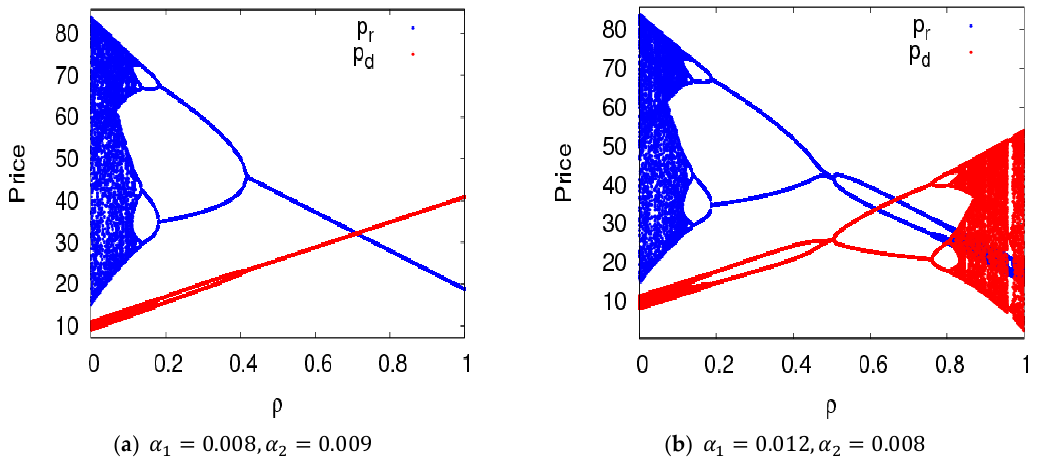
Figure 7. The evolution characteristics of dynamic System (7) when 𝜌 ∈ [0,1].